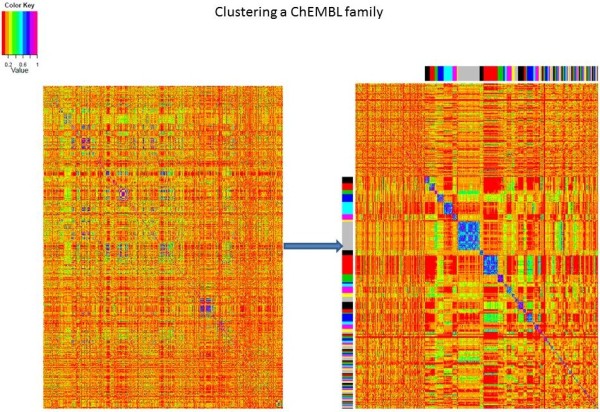
Clustering the CHEMBL1871 family (Androgen Receptor Ligands). The left hand frame shows the compounds in the filtered family in their original order. In the right hand frame, the multi-coloured strips show the proposed restructuring of these compounds into meaningful clusters, with each colour representing a different grouping of structurally similar compounds and hence one of the 126 separate refined families; the top left hand region is populated by singletons.